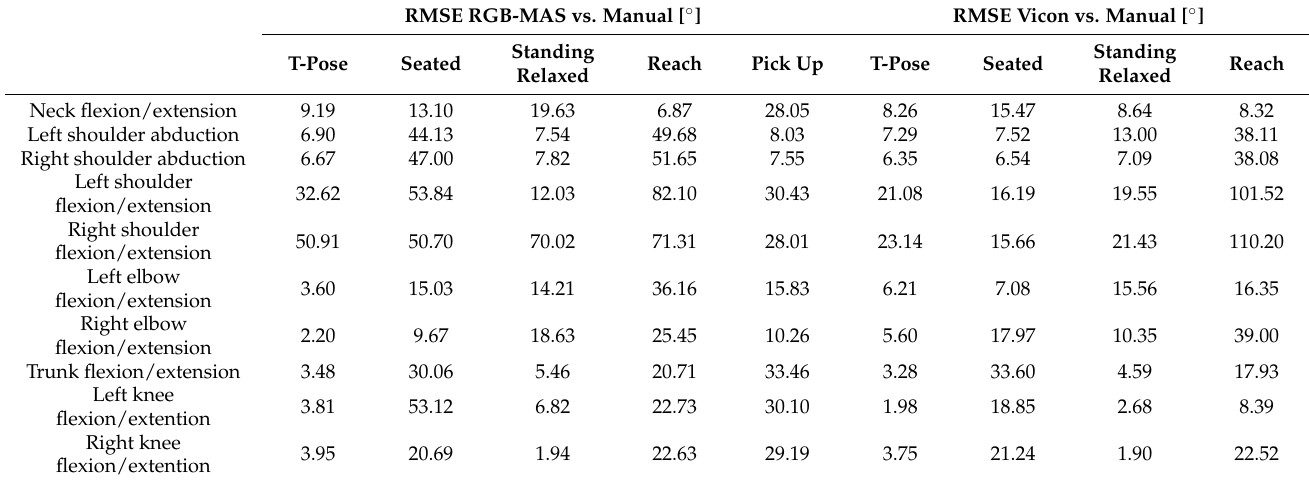
Table 4. RMSE values obtained when comparing RGB-MAS angles with manually extracted ones. RMSE RGB-MAS vs. Manual [ ◦ ] RMSE Vicon vs. Manual [ ◦ ] Standing T-Pose Seated Reach Pick Up T-Pose Seated Relaxed